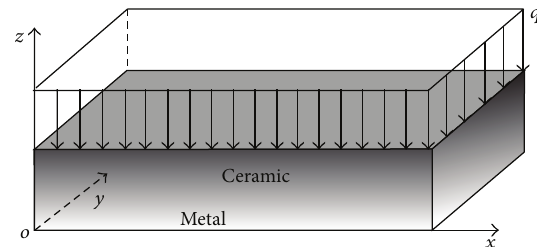
Figure 4: FGM plate subjected to distributed